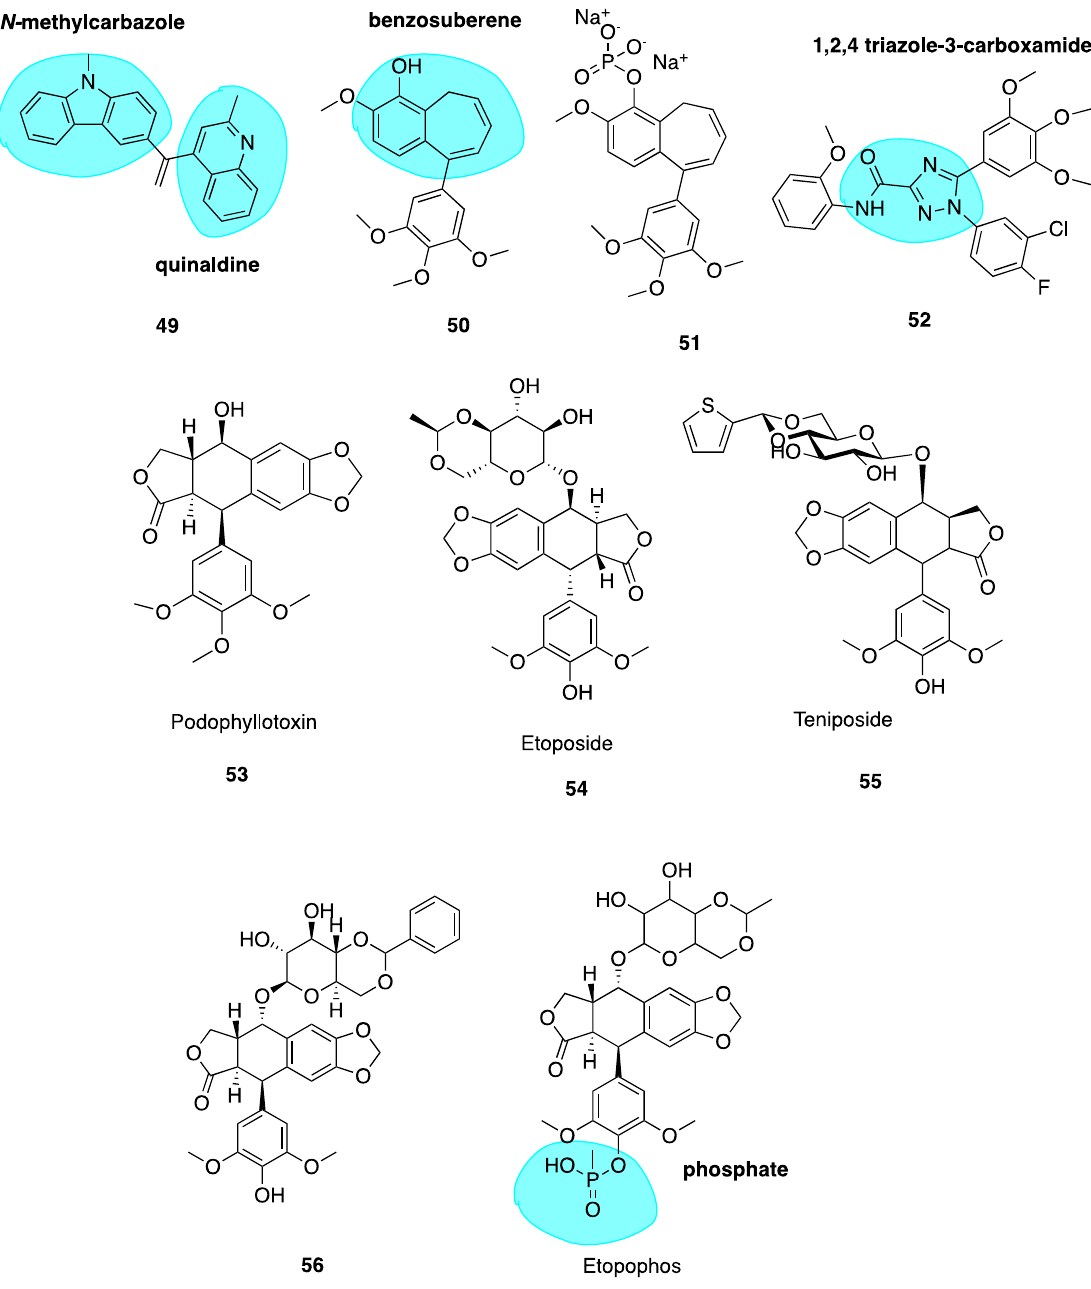
Figure 8. Structures of heterocyclic iso CA-4 derivative 49 , novel benzosuberene analogues 50 and 51 ,